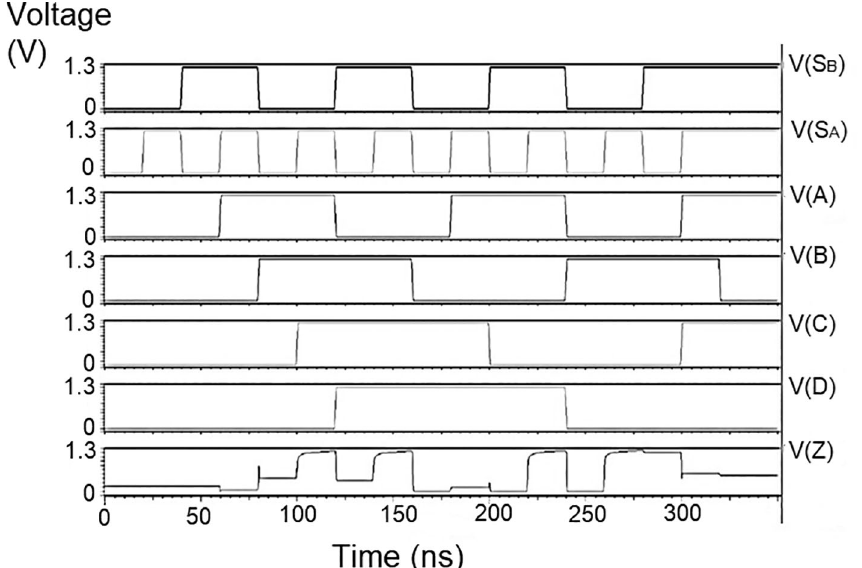
Figure 6(b). Voltage vs time simulation at 1.3 V for 180